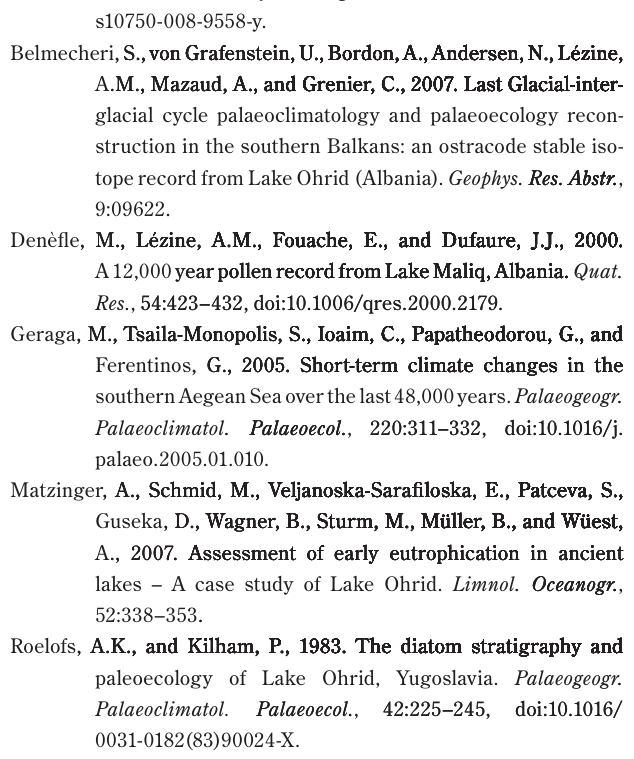
Fig. 2: photo by T. Wilke: photo by T. Wilkephoto by T.